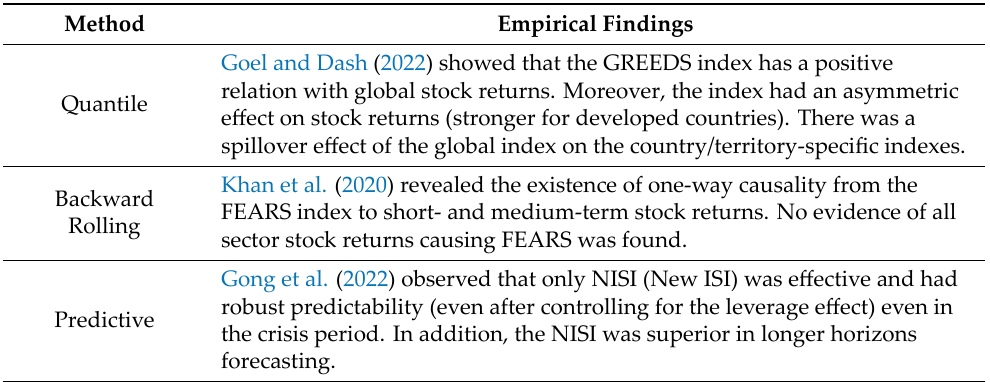
Table 7. Regression